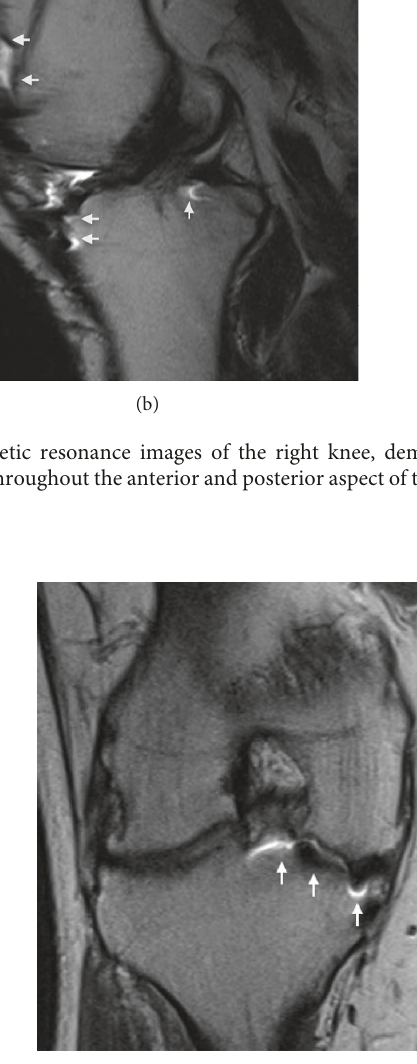
Figure 2: Coronal proton density with metal reduction MRI of the right knee demonstrates significant image distortion (white arrows) from metallic artifacts, obscuring accurate evaluation of the medial femoral condyle articular